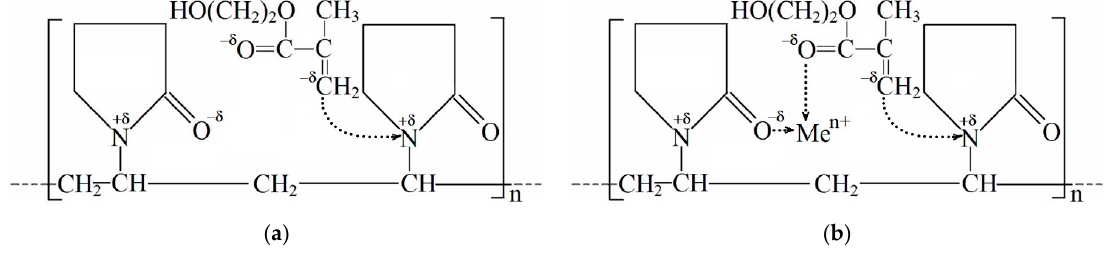
Scheme 1. Complexes with charge transfer: 2-hydroxyethylmethacrylate (HEMA)/polyvinylpyrrolidone (PVP) ( a ) and HEMA/Me n+ /PVP ( b ).